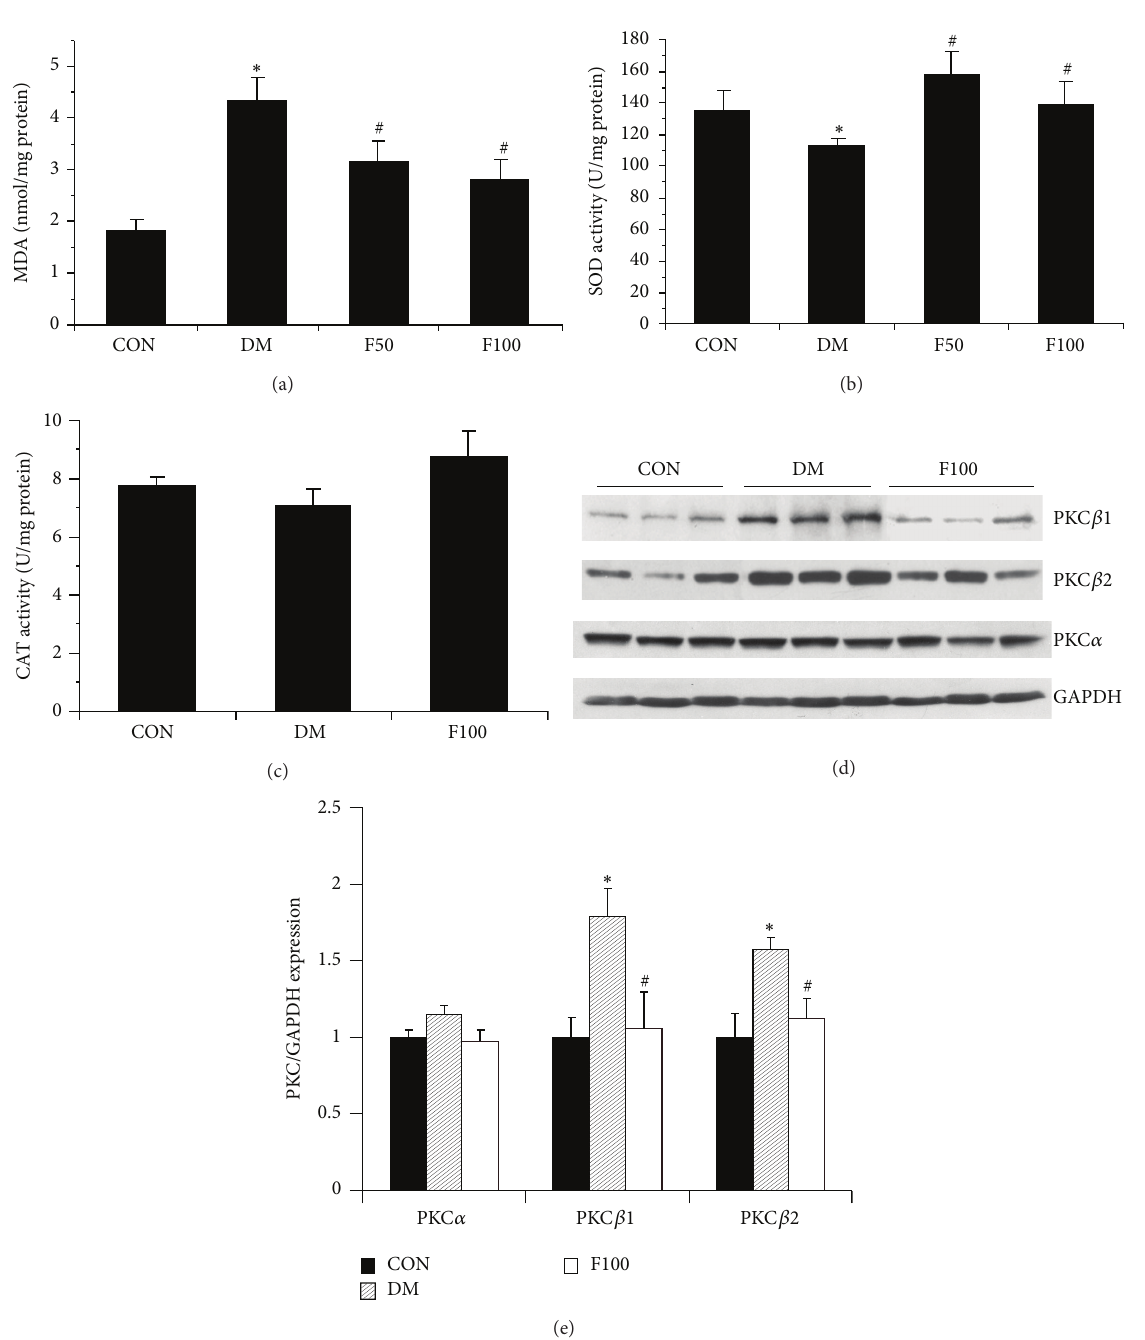
Figure 5: LMWF reduced oxidative stress in diabetic GK rats. Administration with 50 and 100 mg/kg/day LMWF decreased MDA content (a) and increased SOD activity (b) in cardiac tissues of diabetic rats. (c) Administration with 100 mg/kg/day LMWF has no significant effect on the CAT activity of cardiac tissue in diabetic rats. ∗ 𝑃 < 0.05 versus control group, # 𝑃 < 0.05 versus DM group. 𝑁 = 8–10 in each group. (d) WesternblotswereperformedtodeterminetheexpressionofPKC 𝛽 1,PKC 𝛽 2,andPKC 𝛼 incardiactissuesofeachgroup.(e)Thedensitometry value of PKC was normalized to that of GAPDH and data are presented as the mean ± SEM. The statistical analysis was performed. ∗ 𝑃 < 0.05 versus control group, # 𝑃 < 0.05 versus DM group. 𝑁 = 9 in each